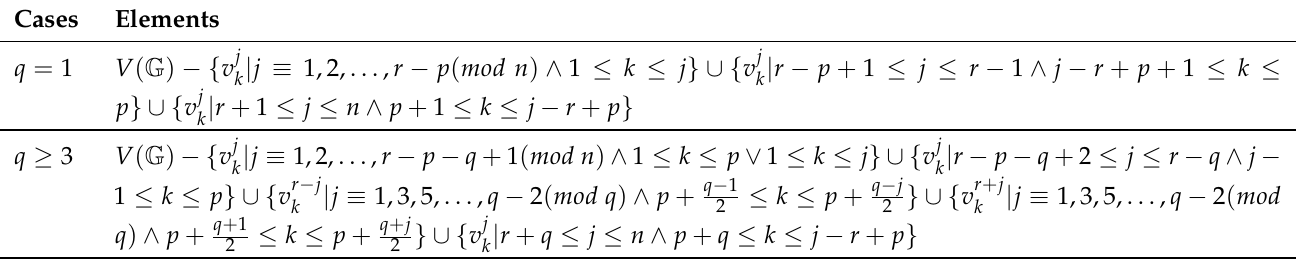
Table 1. ´ R 1 = R { v r p , v r p + q } .